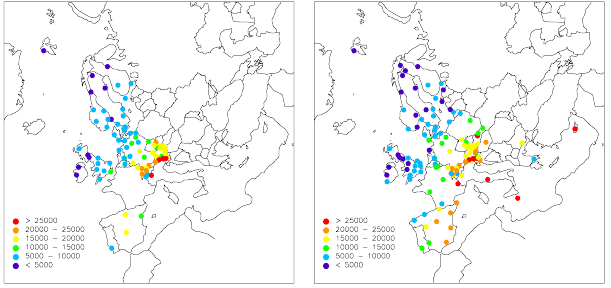
Fig. 14. Ten years mean of the 6-months’ AOT40 (April– September) for the years 1990–1999 (left) and 2000–2009 (right). Unit: ppb h.